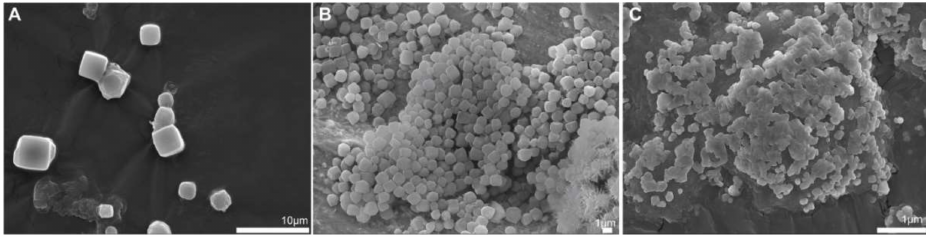
Figure 2. Scanning electron microscopy (SEM) of the purified recombinant OBs. ( A ) Native AcMNPV OB; ( B ) 6xHis-polh OBs; and ( C ) 6xHis-R1-polh OBs (Scale bar = 1 or 10 µ